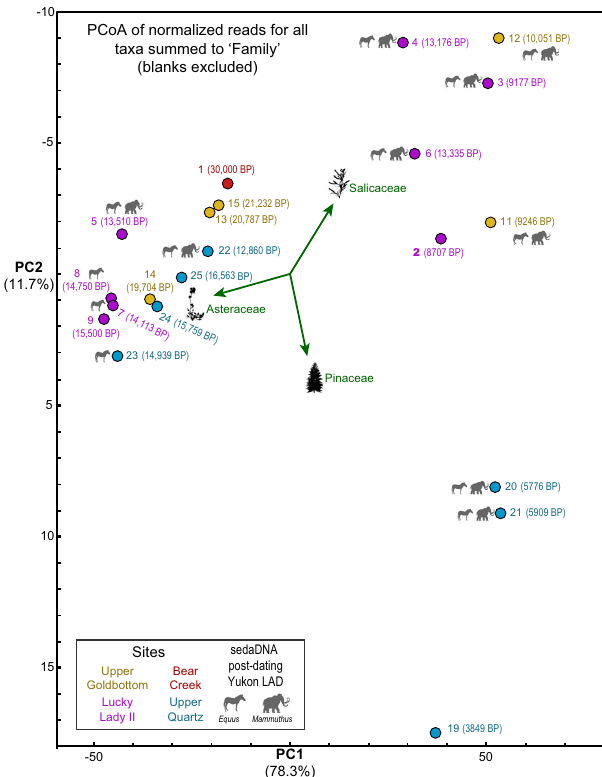
Fig. 6 Metagenomic Principal Coordinates Analysis (PCoA) produced in MEGAN using a chi-square ecological index 187 . LAD last appearance date based on dated macrofossils (Fig. 2). Source data are provided as a Source Data fi